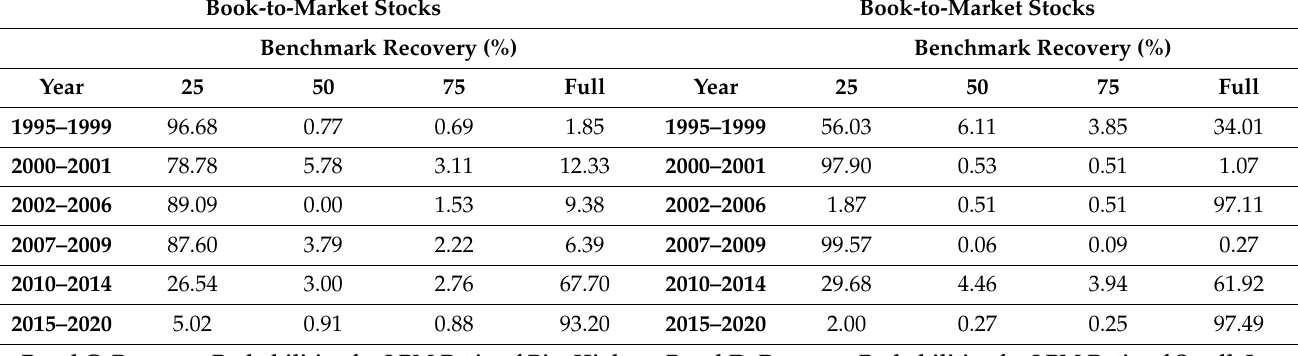
Panel C: Recovery Probabilities for LPM Ratio of Big–High Panel D: Recovery Probabilities for LPM Ratio of Small–Low Investment Stocks Investment Stocks Benchmark Recovery (%) Benchmark Recovery